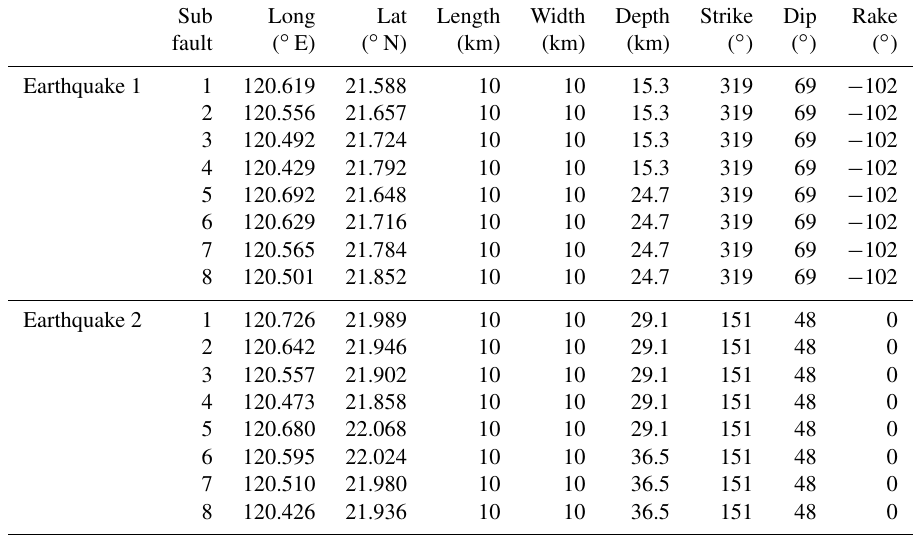
Table 3. Parameters of the subfaults for the two earthquakes of the 2006 earthquake doublet. Sub Long Lat Length Width Depth Strike Dip Rake fault (km)